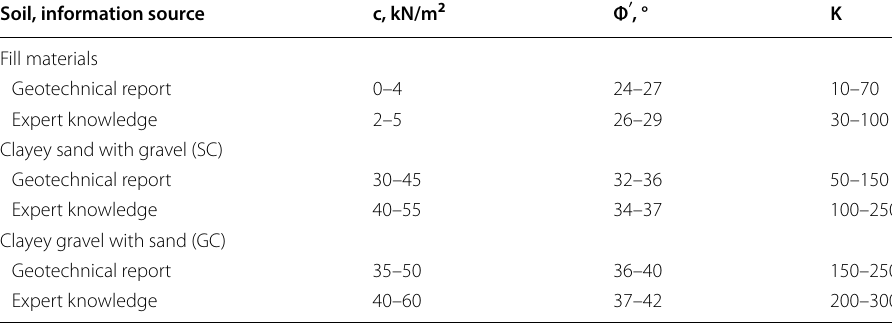
Table 3 Basic variables for material parameters (input values) Soil, information source c, kN/m